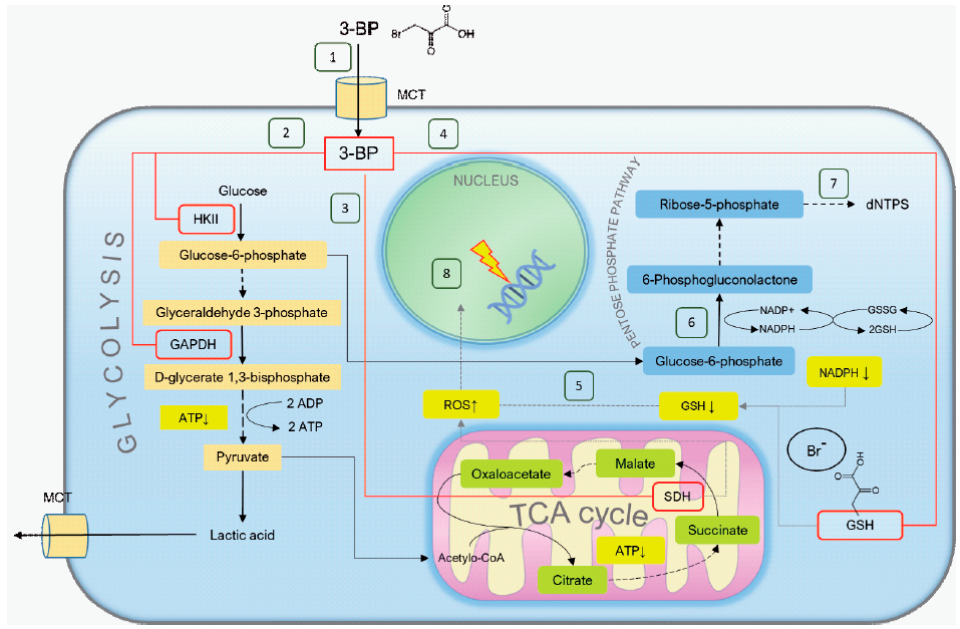
Figure 8. Proposed 3-bromopyruvate mechanism of action: (1) 3-bromopyruvate enters cells through MCTs (mono-carboxylate transporters), which are overexpressed in many cancer cells. (2) Following 3-BP entrance the molecule reacts with cysteine residues of proteins, leading to loss of tertiary structure and function [73]. 3-BP reacts with glycolysis enzymes hexokinase 2 (HKII) and glyceraldehyde 3-phosphate dehydrogenase (GAPDH), leading to depletion of ATP. Moreover, 3-BP inhibits succinate dehydrogenase (SDH), respiratory complex II, which oxidizes succinate to fumarate (3) [74], which can lead to disruption of ATP synthesis and the electron transport chain causing electron leakage and generation of reactive oxygen species (ROS) (4) [75,76]. 3-BP reacts with the cysteine moiety in glutathione (GSH) (4), the main ROS scavenger, leading to its depletion and increase of ROS levels (5) [19,21]. In addition, 3-BP can cause inhibition of the pentose phosphate pathway (PPP) due to hindrance of glucose-6-phosphate formation (6), which in turn can lead to a fall in NADPH and further GSH depletion. dNTP levels could be decreased and PPP is a major source of dNTP precursors (7) [77]. ROS can enter the nucleus and cause oxidation of DNA bases and DNA breaks (8) [78]. DNA damage can be exacerbated by smaller dNTP pools, which are crucial for DNA repair and cell survival [63,64].